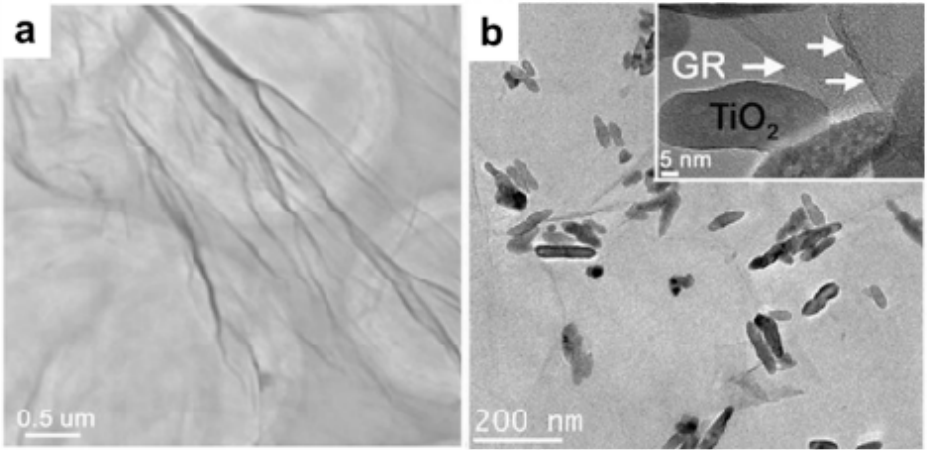
Figure 9. TEM images of ( a ) GO and ( b ) 0.1-TiO 2 − x /GR composite [172] (Reprinted with permission from [172] Copyright 2014 Springer Nature Ltd.).